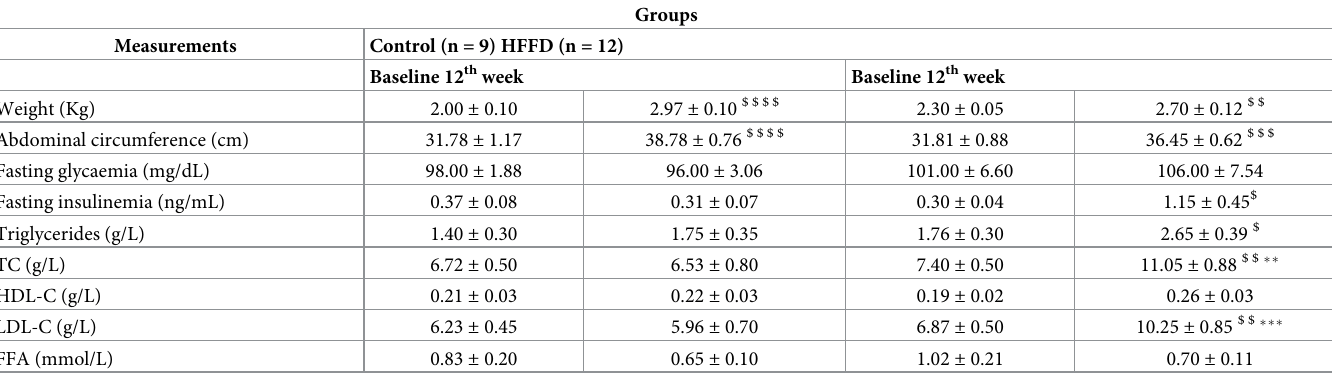
Table 1. Results of weight, abdominal circumference, glycaemia, insulin and plasma